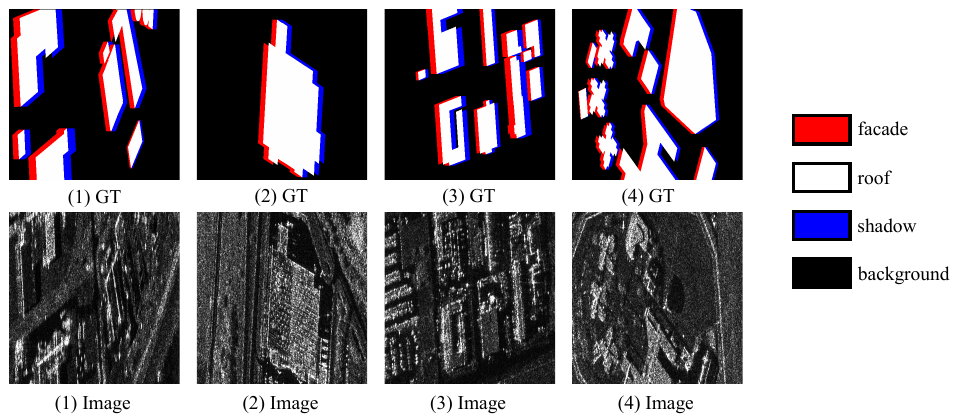
Figure 8. A display diagram of some data in the dataset and the correspondence between different colors and categories in the GT image are